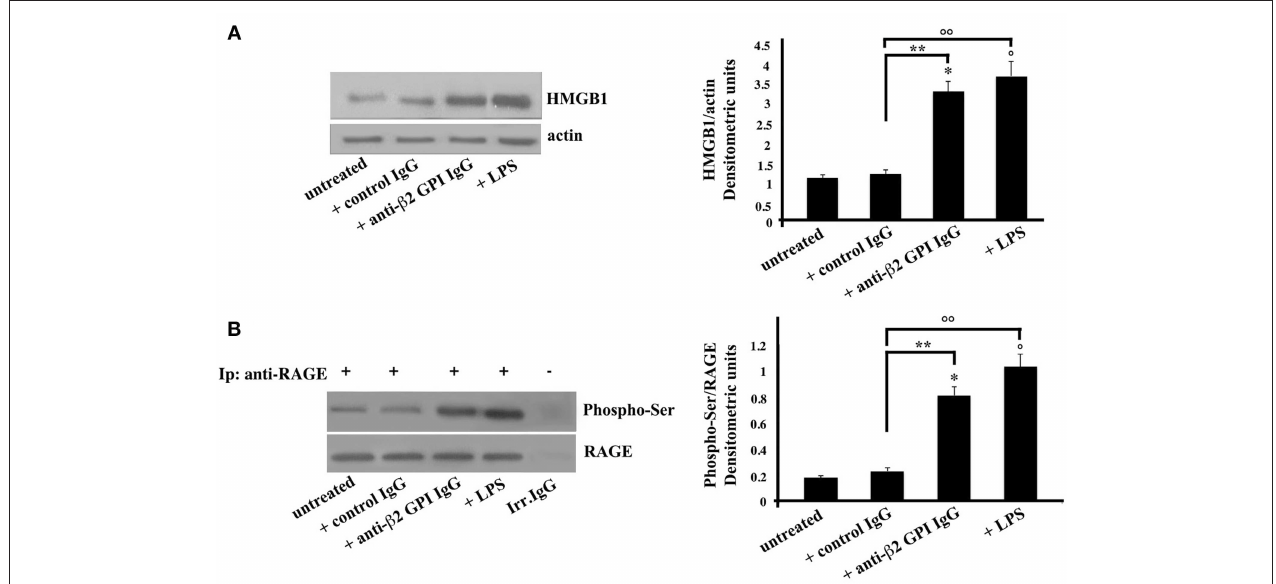
FIGURE 2 | Anti- β 2 -GPI antibodies induce an increase of HMGB1 expression and RAGE activation in platelets. (A) Platelets from healthy donors, untreated or treated with control human serum IgG (200 µ g/ml), human affinity-purified anti- β 2 -GPI IgG (200 µ g/ml) or LPS (100ng/ml) for 4h at 37 ◦ C, were analyzed by Western Blotting using rabbit anti-HMGB1 polyclonal Ab. Expression of HMGB1was detected and representative images of three independent experiments were shown. Right panel: the ratio of HMGB1 immunopositivity to actin was calculated. The results are expressed as mean ± SD from 3 independent experiments. * p + anti- β 2 -GPI IgG < 0.001 vs. untreated, ◦ p + LPS < 0.001 vs. untreated, ** p + anti- β 2 -GPI IgG < 0.001 vs. + control IgG, ◦◦ p + LPS < 0.001 vs. + control IgG. (B) Human platelets, untreated, or treated as above were lysed in RIPA buffer. Cell lysates were prepared and immunoprecipitated with goat anti-RAGE polyclonal Ab. Immunoprecipitates were analyzed using mouse anti-Phospho-Ser mAb. Immunoprecipitation was checked by mouse anti-RAGE monoclonal Ab. Right panel, densitometric Phospho-Ser /RAGE ratios are shown. Results represent the mean ± SD from 3 independent experiments. *p + anti- β 2 -GPI IgG < 0.001 vs. untreated, ◦ p + LPS < 0.001 vs. untreated, ** p + anti- β 2 -GPI IgG < 0.001 vs. + control IgG, ◦◦ p + LPS < 0.001 vs. + control